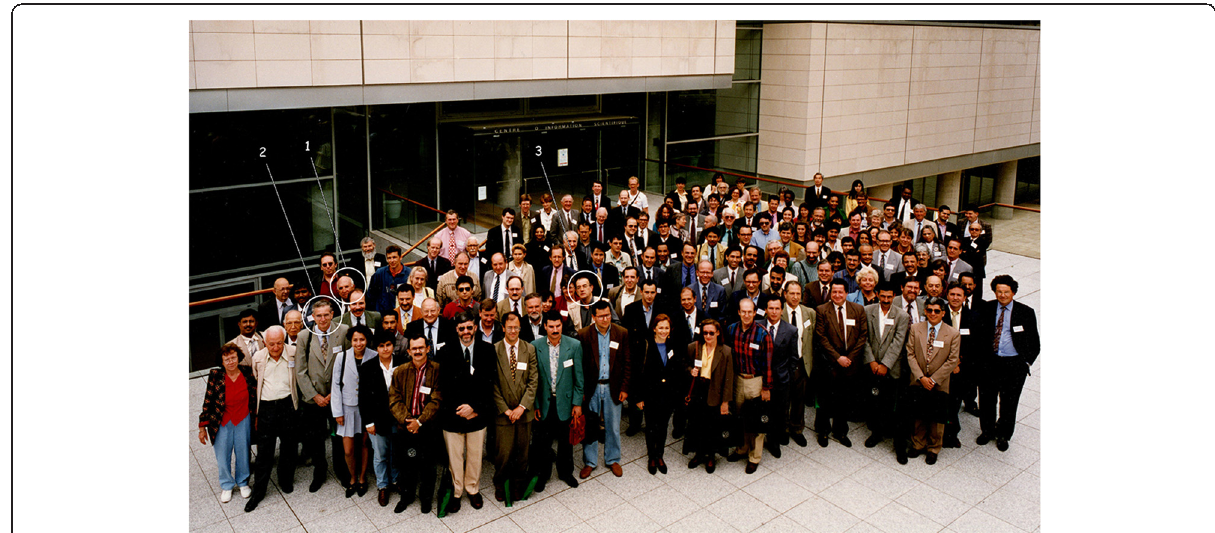
Figure 4 Official photo of the 1 st International Congress on Envenomations and Their Treatments which took place at the Pasteur Institute, Paris, in 1995. (1) C. Diniz, (2) M. Goyffon, (3) W. R.